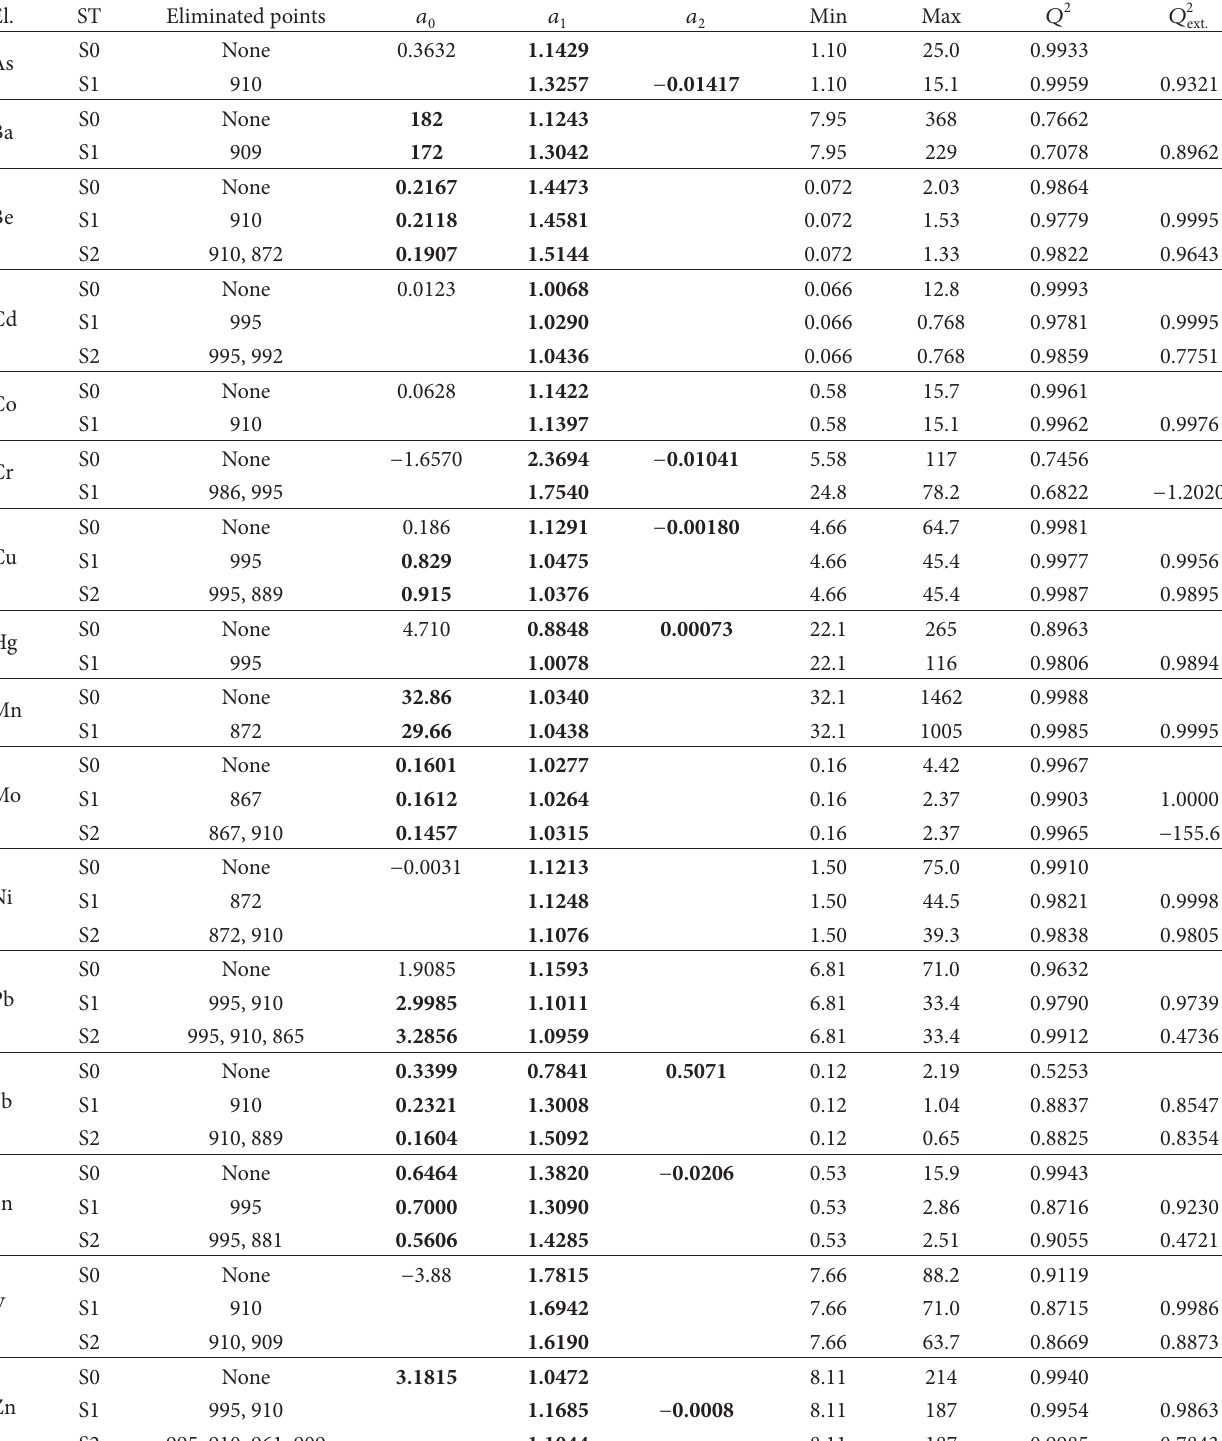
T 5: Summary of consecutive stages of stepwise polynomial